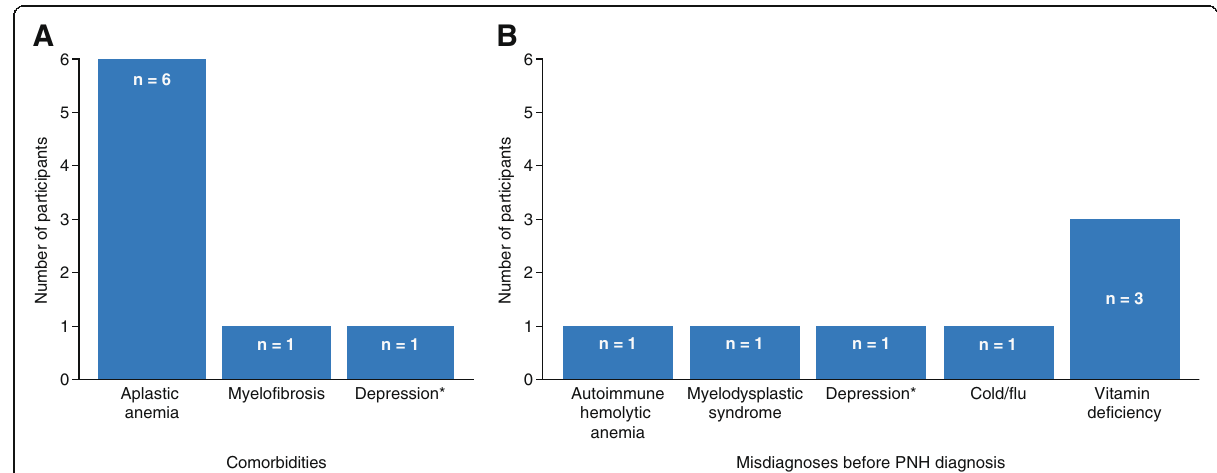
Fig. 1 Participant-reported comorbidities ( a ) and misdiagnoses before PNH diagnosis ( b ). PNH paroxysmal nocturnal hemoglobinuria. *Depression was mentioned by two different participants as a comorbidity or misdiagnosis